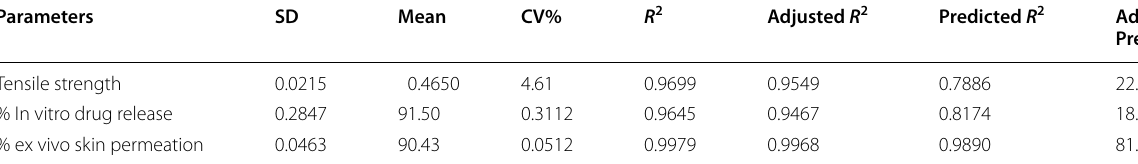
CV Coefficient of variation, SD Standard deviation